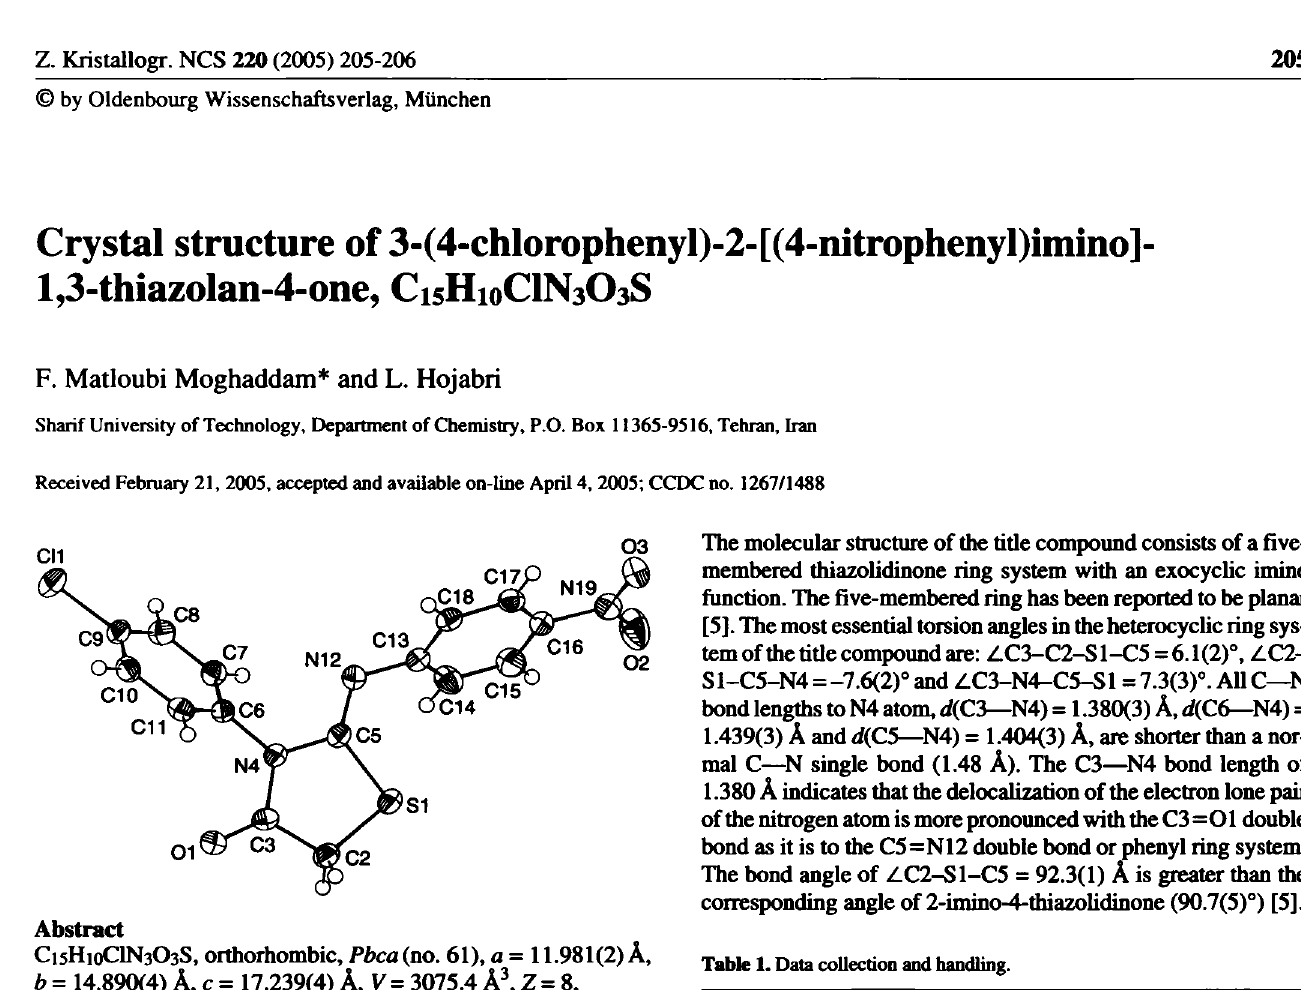
Table 2. Atomic coordinates and displacement parameters (in Ä 2 ).